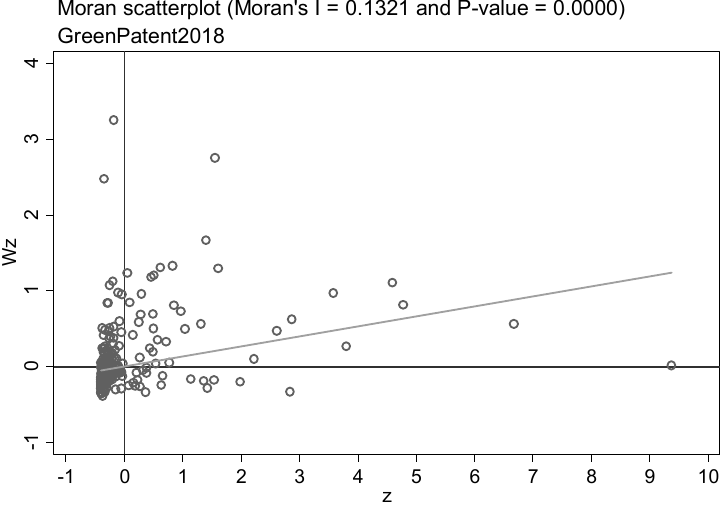
Figure 4. Scatter plots of the local Moran’s index of green patents in China’s cities in 2018. However, the spatial spillover effects of variables cannot be directly evaluated by the coefficients of explanatory variables and their spatial lag terms in Column (1) of Table